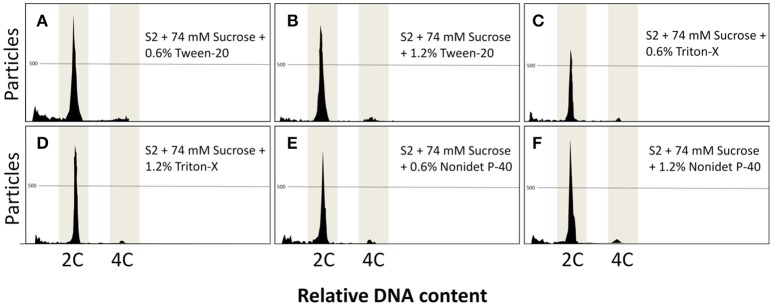
(A–F) Flow cytometric charts of fin samples using various lysing treatments and staining with DAPI. A combination of solution S2 with Triton-X, Tween-20, and Nonidet P-40 at 0.6 and 1.2% and 74 mM sucrose was evaluated. All treatments gave rise to clear peaks.